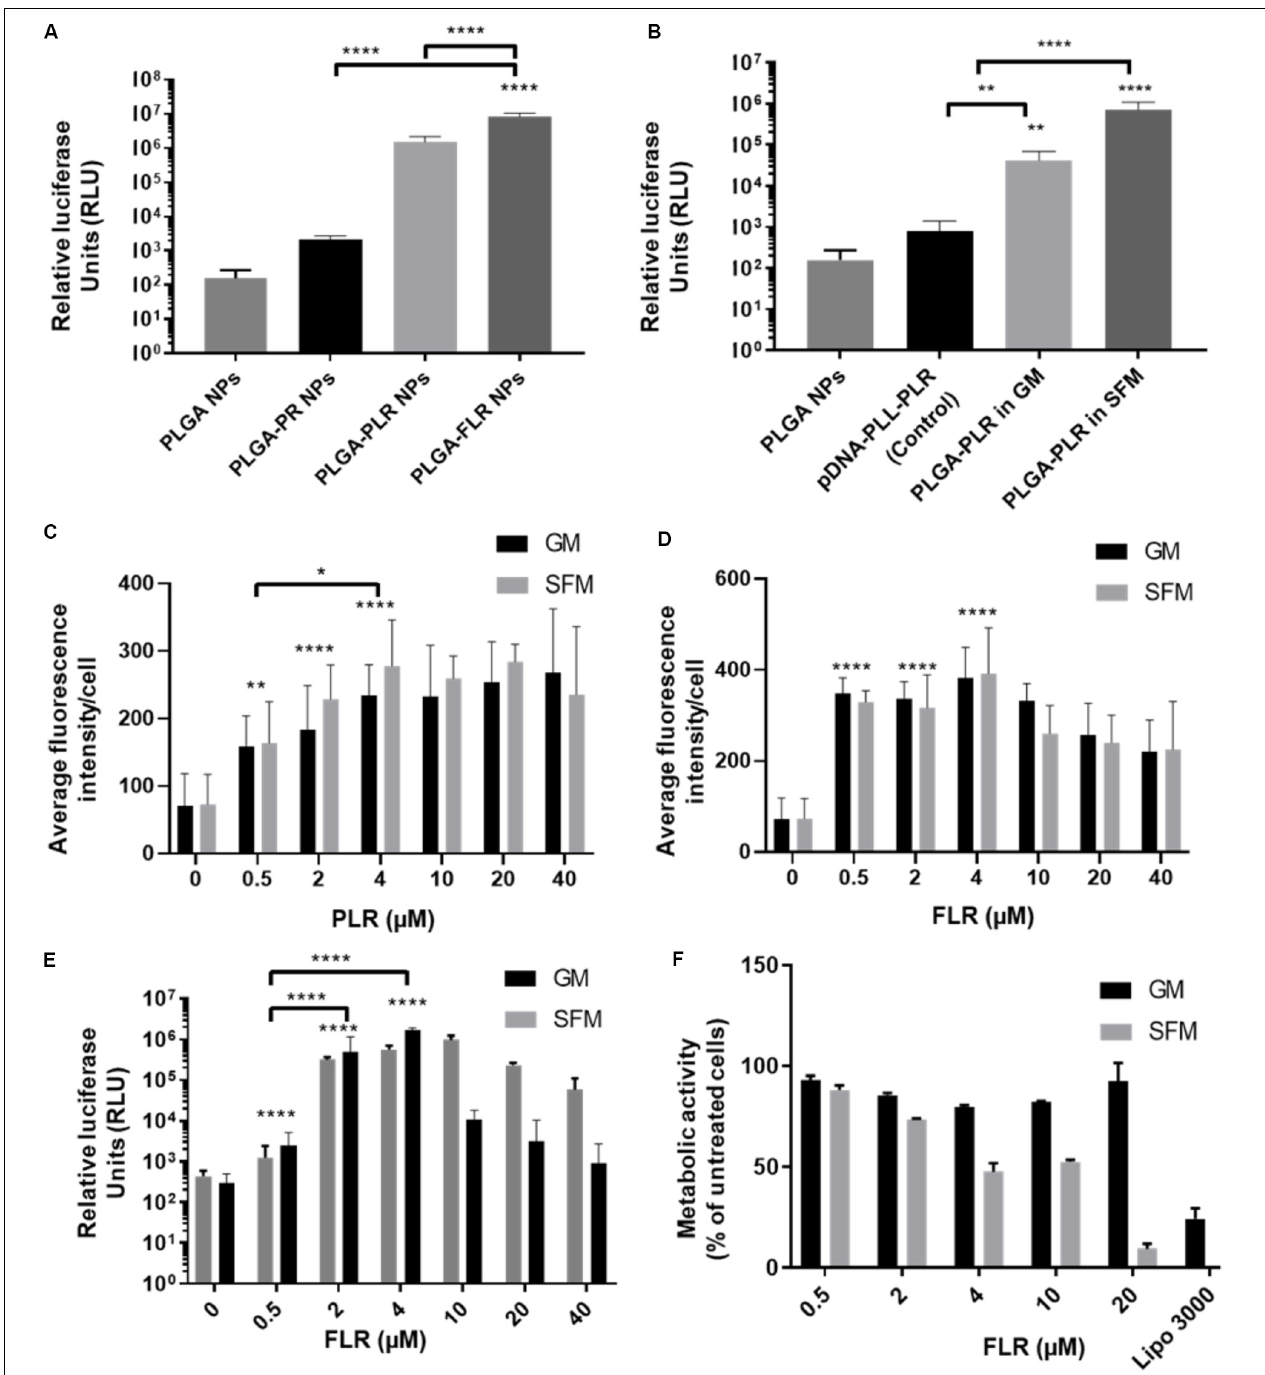
FIGURE 4 | Enhanced transfection of PLGA NPs with GET. (A) Levels of transfection of different GET peptide complexation showing high levels of transfection of pDNA encapsulated PLGA NPs complexed with PLR and FLR in NIH3T3 cells, Corresponding 1 µ g of pDNA content. (B) Validation of the encapsulated pDNA and the ability to transfect against controls (pDNA-PLL). Dose optimization of PLR (C) and FLR (D) peptides in IHMSCs. Transduction level increases with increasing the dose of both PLR and FLR. Enhancement reaches saturation at 4 µ M FLR peptide. (E) Dose dependent enhanced transfection of IHMSCs, as a result of enhanced transduction by FLR. In line with transduction levels, with increasing FLR peptide concentration, the transfection levels improve until reaching saturation. (F) Cell metabolic activities 24-h after transfection with different doses FLR (highest transduction activity) in IHMSCs. In contrast to Lipofectamine 3000, FLR peptide show high margins of cytocompatibility especially in GM. The asterisk over the bars indicate significance to control (PLGA NPs), the asterisk over the lines indicate significance between groups. One-way and two-way Anova statistical analysis was used to generate the graph followed by Tukey test to determine significant differences between each mean. The data represented as mean ± SD. Where significance was ** or ****, P -value was < 0.0021, or < 0.0001 respectively.